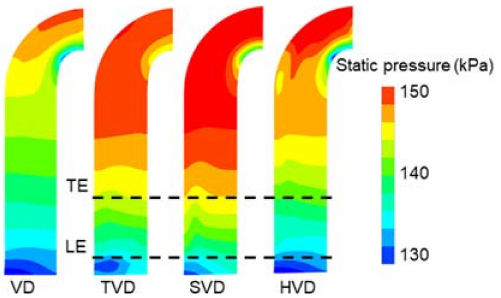
Figure 9. Distribution of static pressure on diffuser meridional direction at low mass flow rate operating point ( ϕ = 0.7 Q d ).